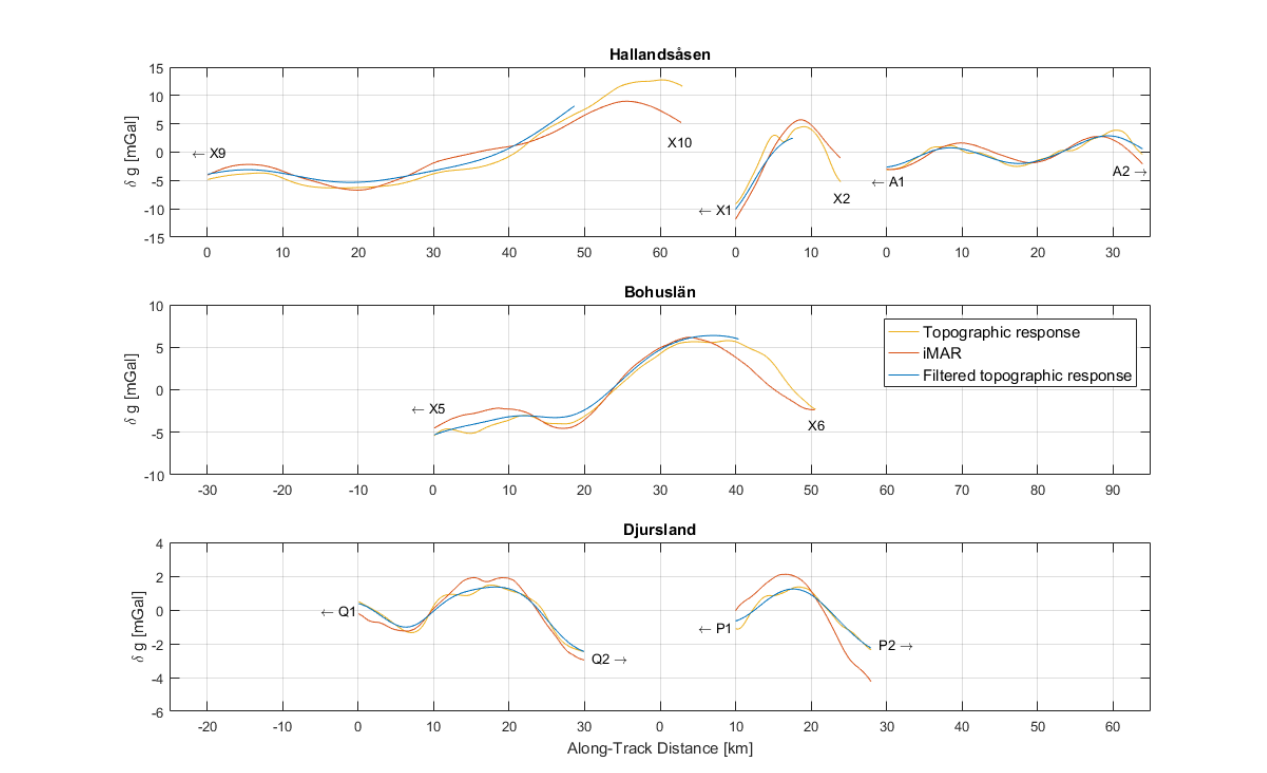
Figure 7. Extracts of iMAR gravity line estimates (red) over land areas with topography along with computed topographic response (yellow) along the flight line. The topographic response is here subjected to a two-pass Butterworth filter with a time constant of 90 s, i.e., half power around 125 s (blue). ( Top ) Flight lines over Hallandsåsen; ( Middle ) Flight line over southern part of Bohuslän; ( Bottom ) Flight lines over Djursland. See Figure 3 for